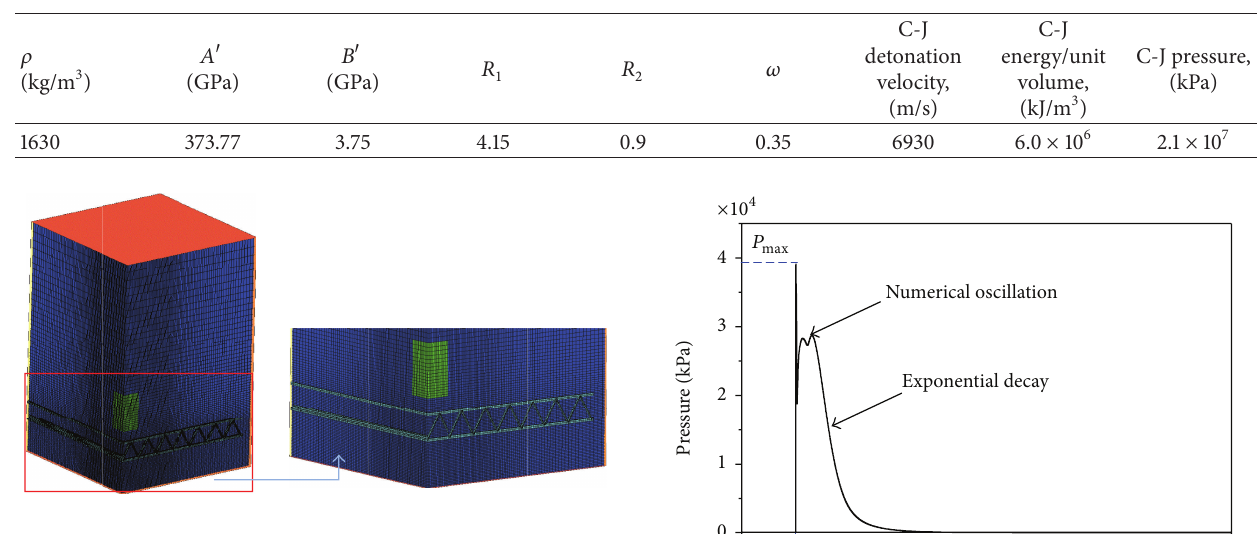
Table 5: Material properties of TNT explosive [20].